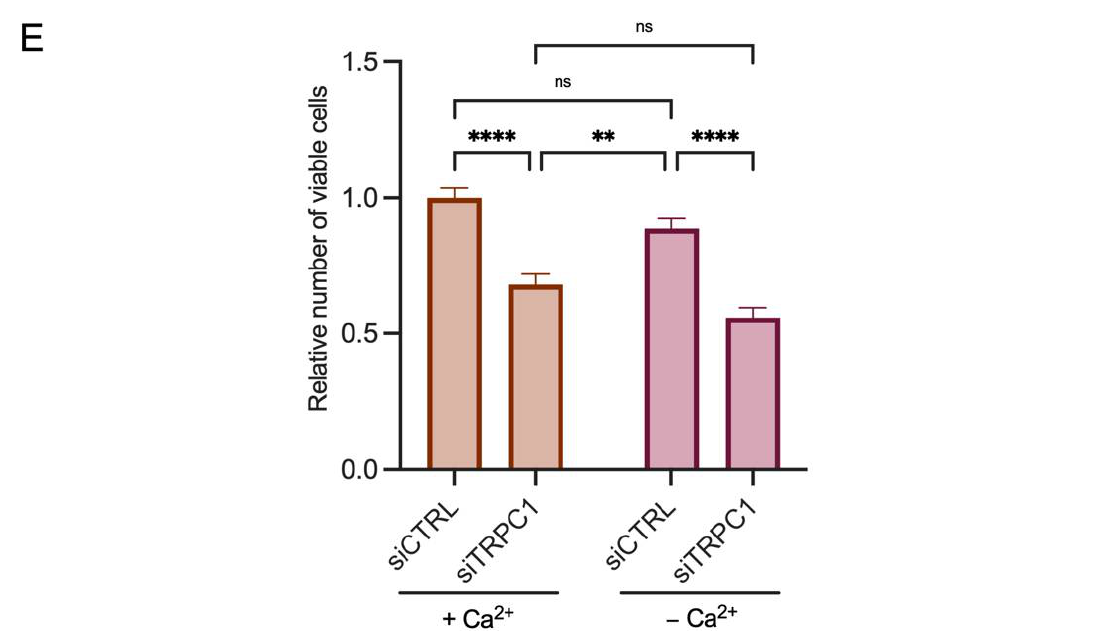
Figure 5. The knockdown of TRPC1 does not affect Ca 2+ entry and the proliferative role of PANC-1 cells does not depend on extracellular Ca 2+ concentration. ( A ) Representative traces of Mn 2+ quenching in PANC-1 cells (left panel) and the quantification of siCTRL and siTRPC1 transfected PANC-1 cells (right panel) (number of analyzed cells siCTRL = 342 and siTRPC n = 382). ns indicates non-significant. ( B ) Representative traces of the classical store-operated Ca 2+ entry protocol. Cells were perfused with 2 mM Ca 2+ for 1 min, then with 0 mM Ca 2+ and 1 µM thapsigargin (Tg) for 12 min, followed by 2 mM Ca 2+ for 5 min, and finally perfused with 0 mM Ca 2+ . ns indicates non- significant. ( C ) Quantification of basal Ca 2+ ratio (0 mM Ca 2+ ) in siCTRL and siTRPC1 transfected PANC-1 cells (number of analyzed cells siCTRL = 303 and siTRPC1 = 280). ns indicates non- significant. ( D ) Quantification of SOCE (2 mM Ca 2 after internal Ca 2+ -store depletion) in siCTRL and siTRPC1 transfected PANC-1 cells (number of analyzed cells siCTRL = 303 and siTRPC n = 280). ( E ) Trypan blue assay analysis of siCTRL and siTRPC1 transfected PANC-1 cells (for 72 h) either treated with medium containing extracellular Ca 2+ concentrations (+Ca 2+ ), or with medium depleted for extracellular Ca 2+ (−Ca 2+ ), for 48 h ( n = 3). Welch’s correction t-test and Tukey’s multiple comparison test ( E ) were used to determine significant difference between siCTRL and siTRPC1 conditions. **, and **** indicate p < 0.01, and 0.0001, respectively .